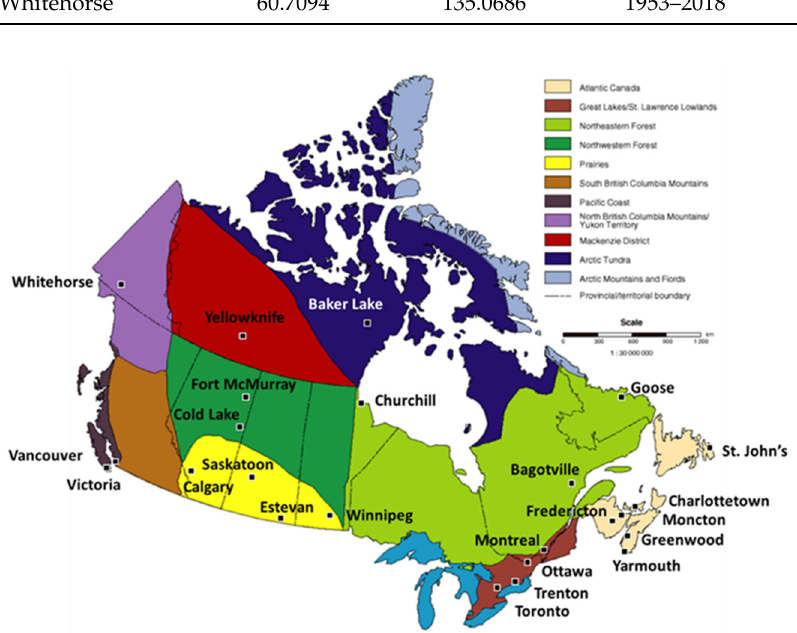
Figure 3. The map of twenty-four locations of weather stations used in this study presented on the map of Canadian climate regions (source: Environment Canada, Atmospheric Environment Service, Climate Research Branch, 1998, Climate Trends and Variation Bulletin for Canada,